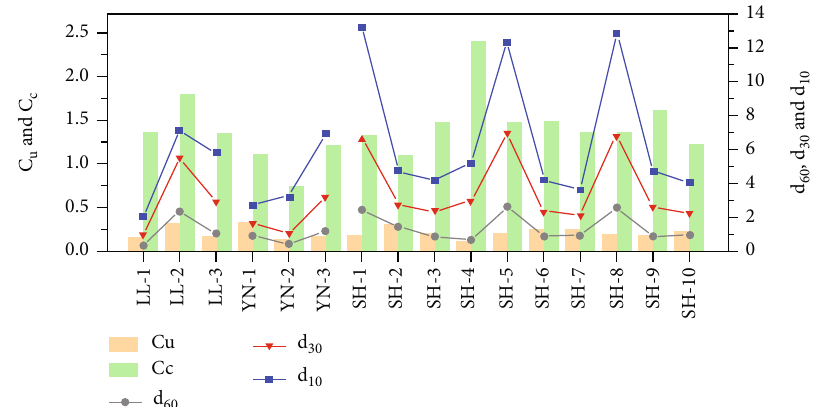
Figure 8: Cutting uniformity